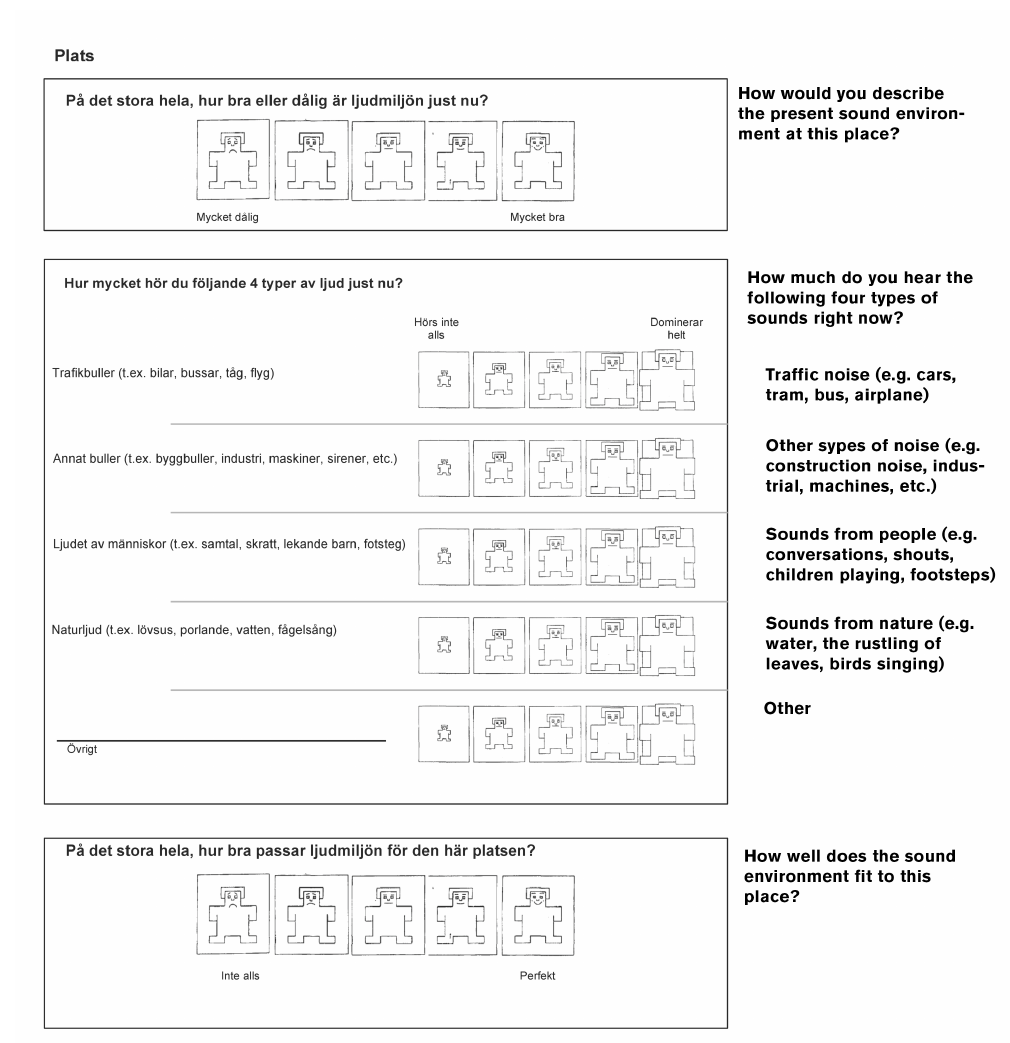
Figure 1. Soundwalk